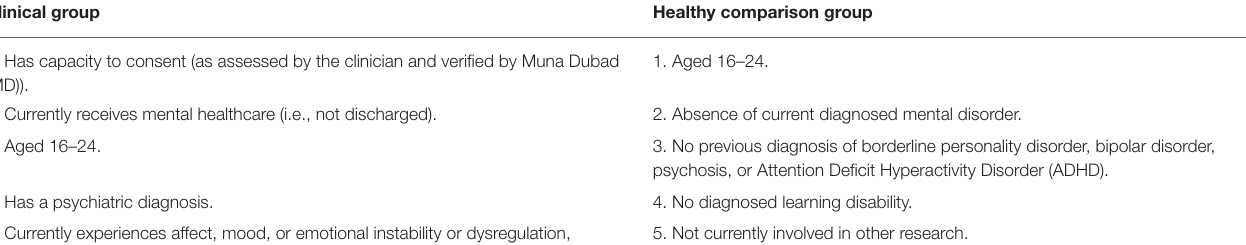
TABLE 1 | Eligibility criteria for the clinical and healthy comparison